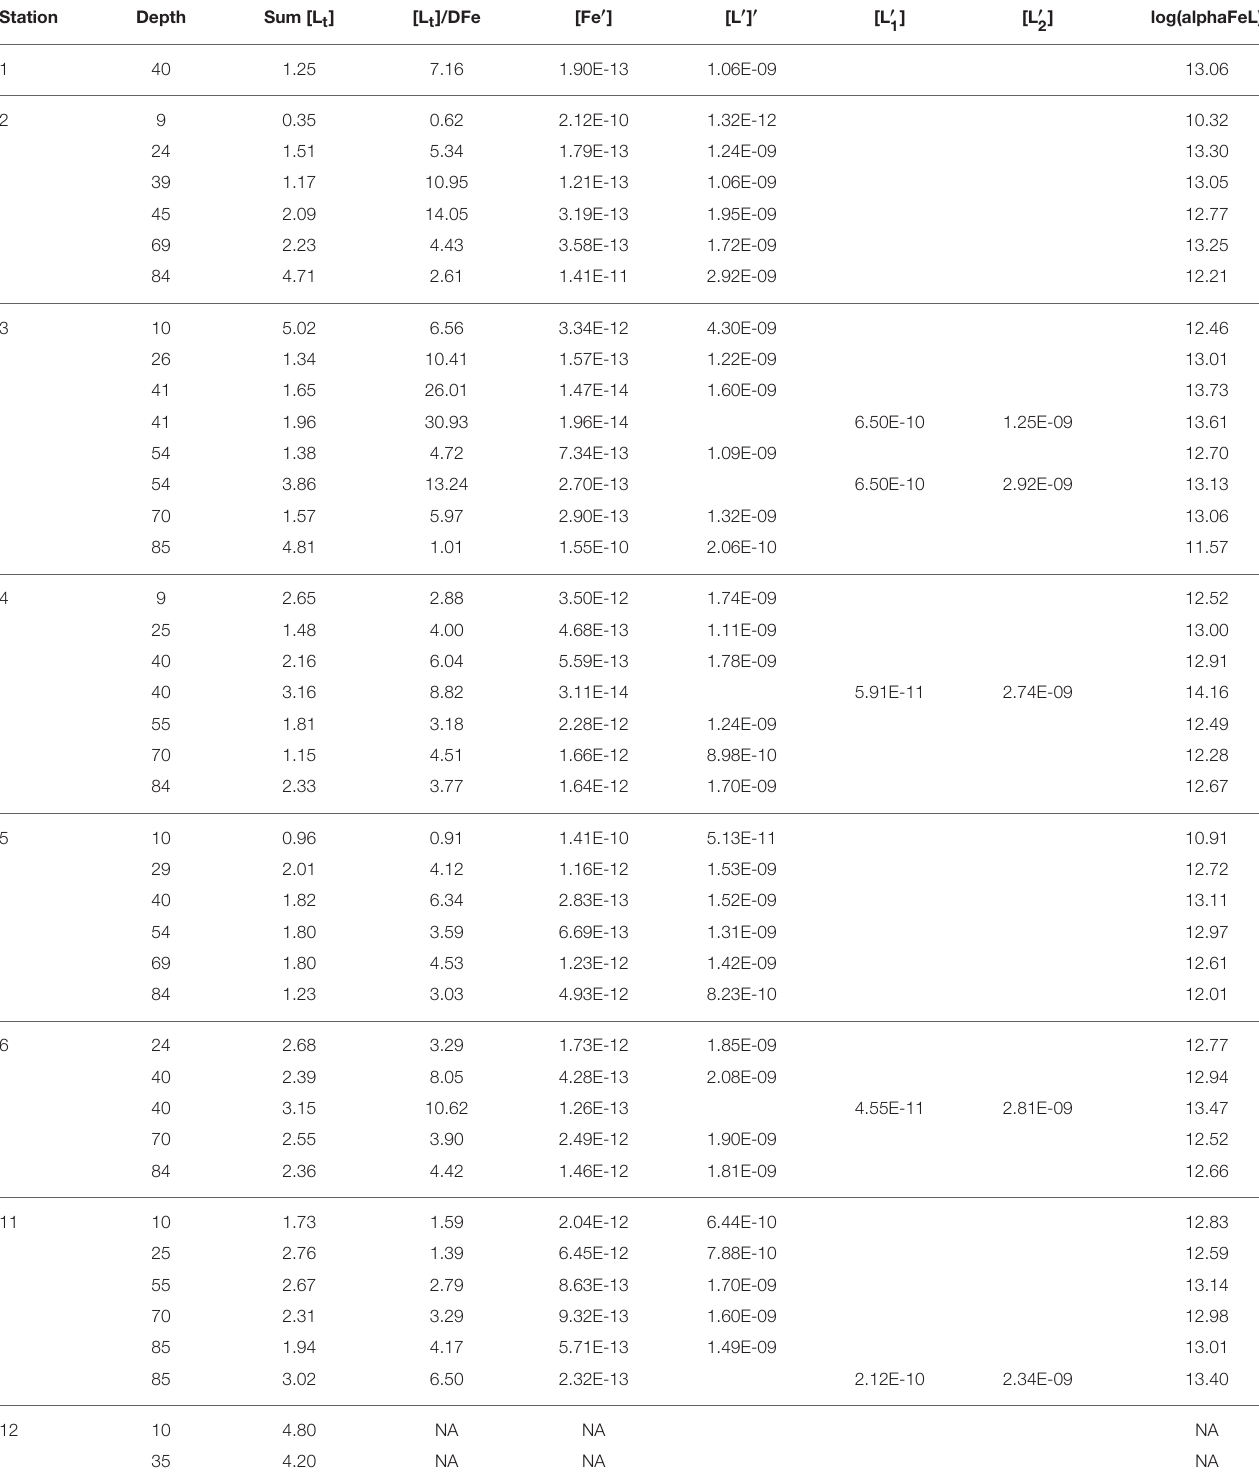
TABLE 1B | The sum of ligands (1 or the sum of 2 ligands concentrations, the ratio between [L t ], or the sum of both ligands, and DFe, log(alphaFeL), (for one or for two ligands), [Fe ′ ] and [L ′ ] (both in M), for one or for two ligand classes, [L ′ 1 ] and [L ′ 2 ], were calculated from the first three variables in Table 1A (see